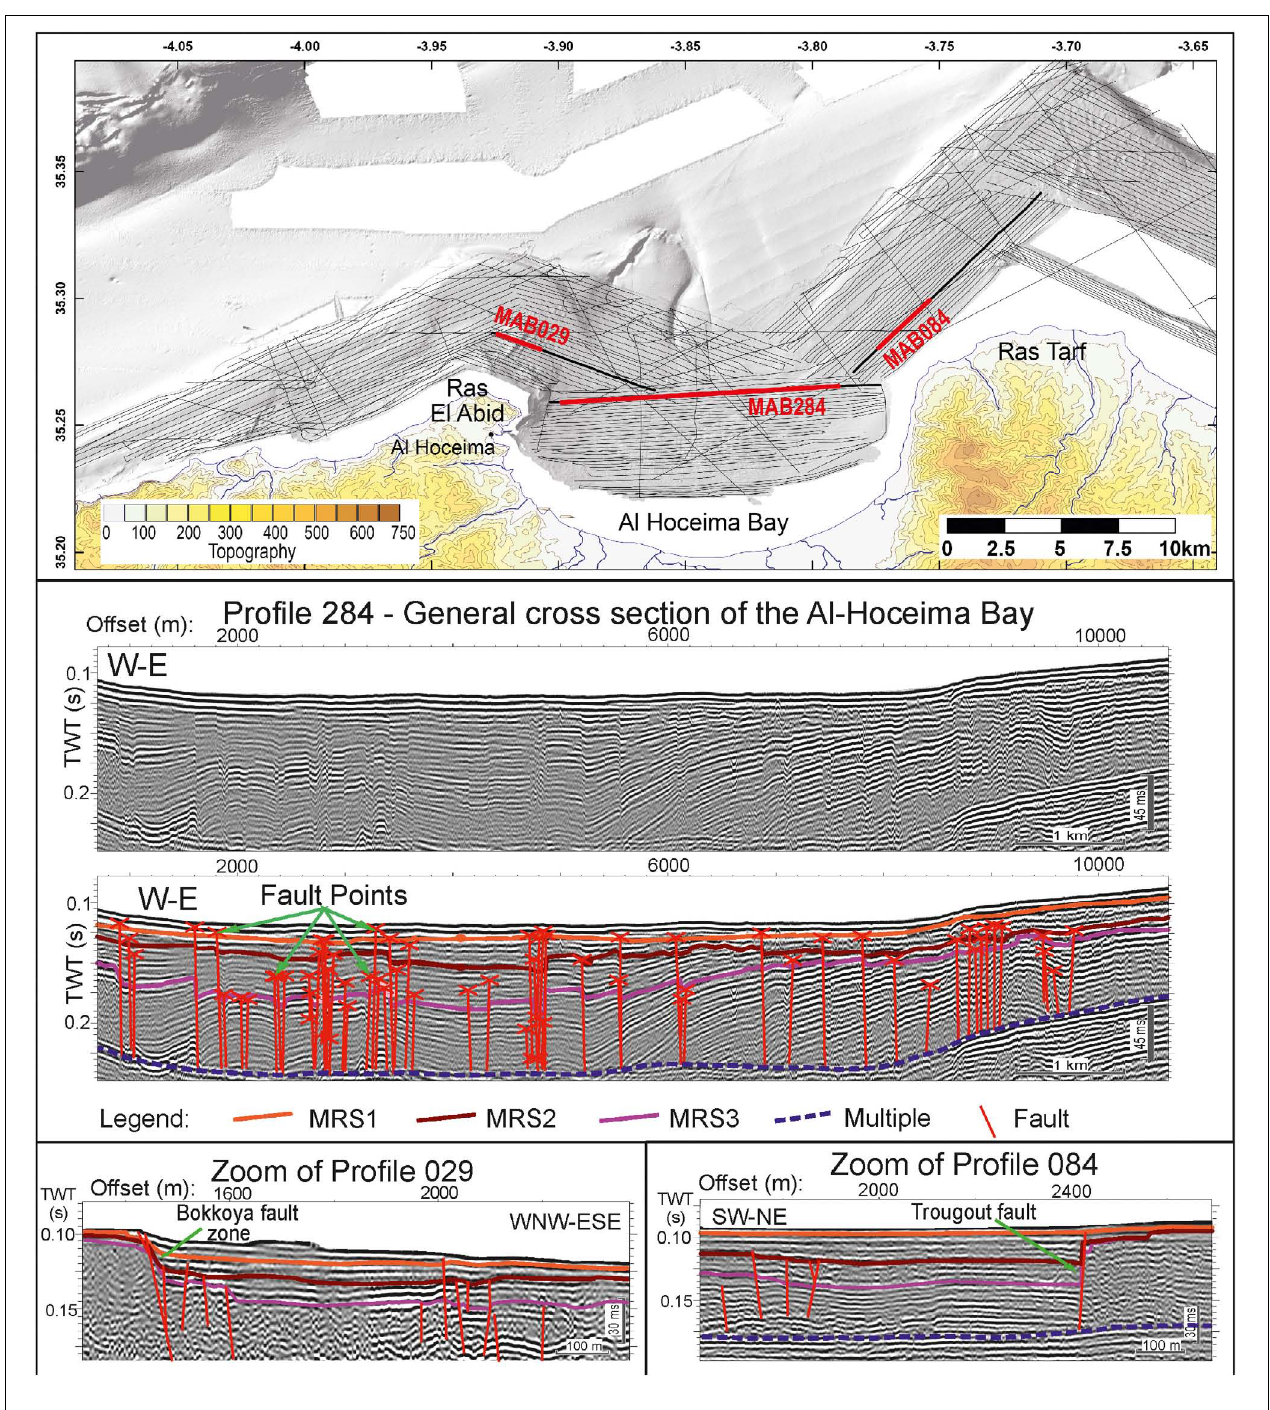
FIGURE 3 | Seismic images of the cross-section of Al Hoceima Bay and details of Bokkoya and Trougout faults on multibeam bathymetric map, including the location of the high-resolution seismic reflection profiles used for this study (Marlboro-2 survey). Profile 284 has been displayed with and without interpretation as a general overview of the Bay. The red “X” represents the fault points displayed in a seismic profile. Magnification of Profiles 29 and 84 are intended to present the Bokkoya fault and the Trougout fault.